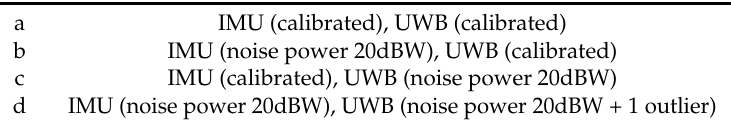
Table 5. Sensor observation study cases.